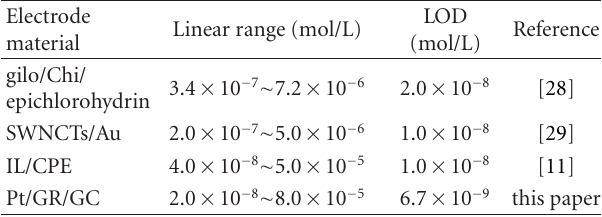
Table 1: Comparison of di ff erent electrodes for rutin determina- tion.